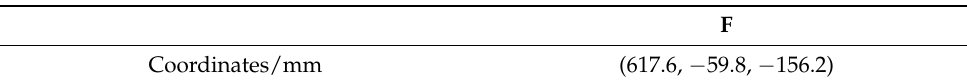
Table 2. Coordinates of striking point.